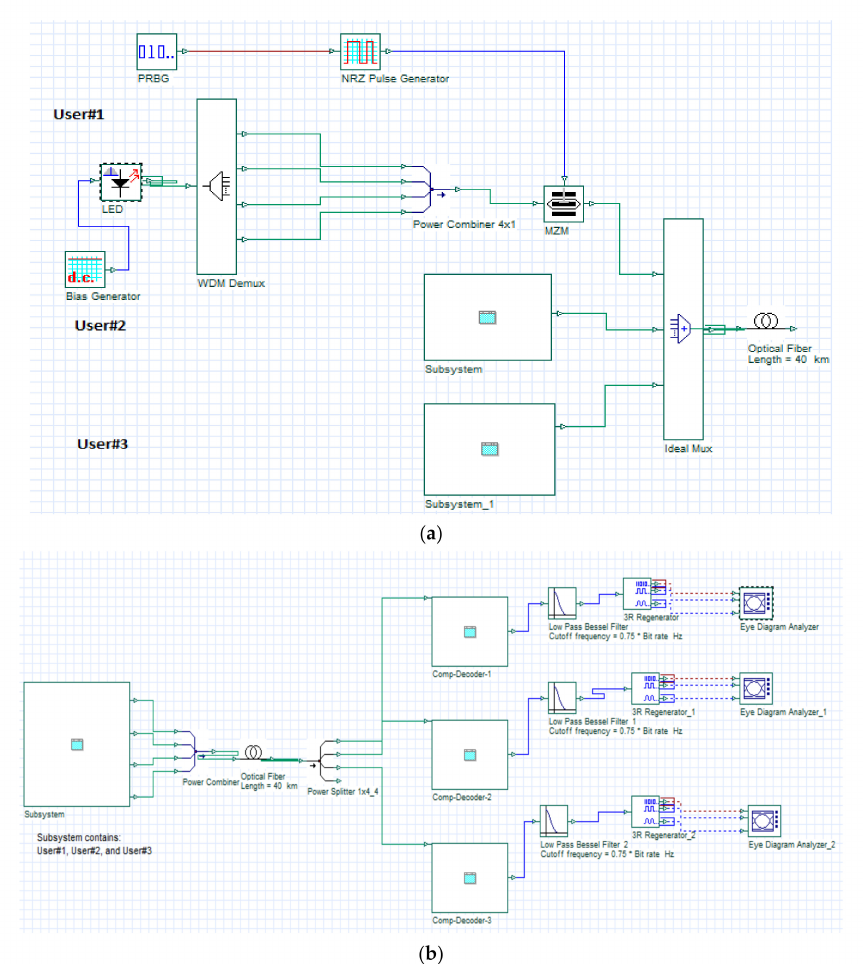
Figure 2. Schematic diagram of DPS code using three users: ( a ) transmitter; ( b ) receiver using CDS detection